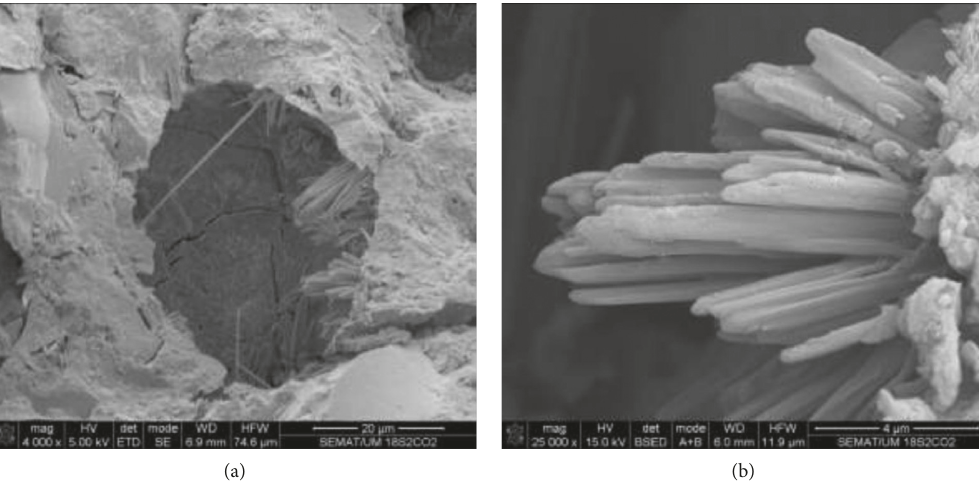
2 SO 4 ; (b) a detail of the formed ettringite crystals.